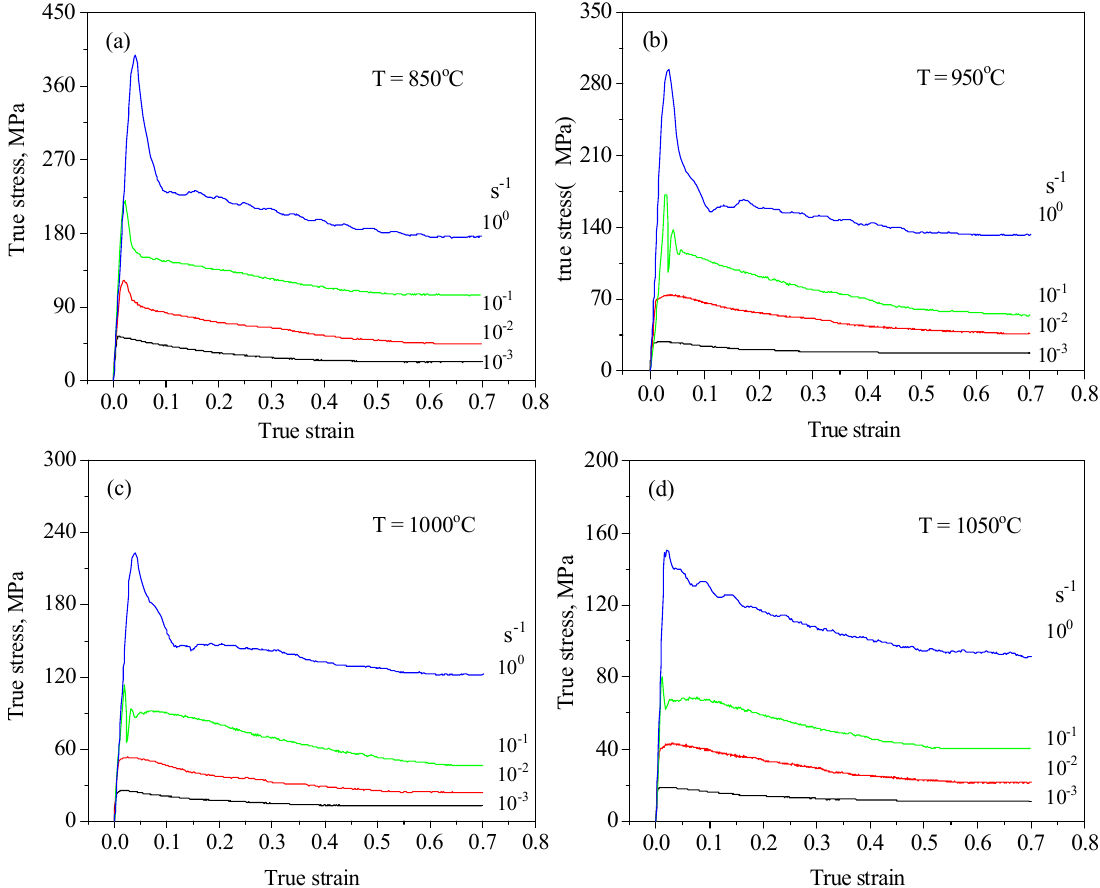
Figure 3. Typical stress–strain curves for the ZrTiAlV alloy at different temperatures [11]. ( a ) T = 850 °C; ( b ) T = 950 °C; ( c ) T = 1000 °C; ( d ) T = 1050 °C.